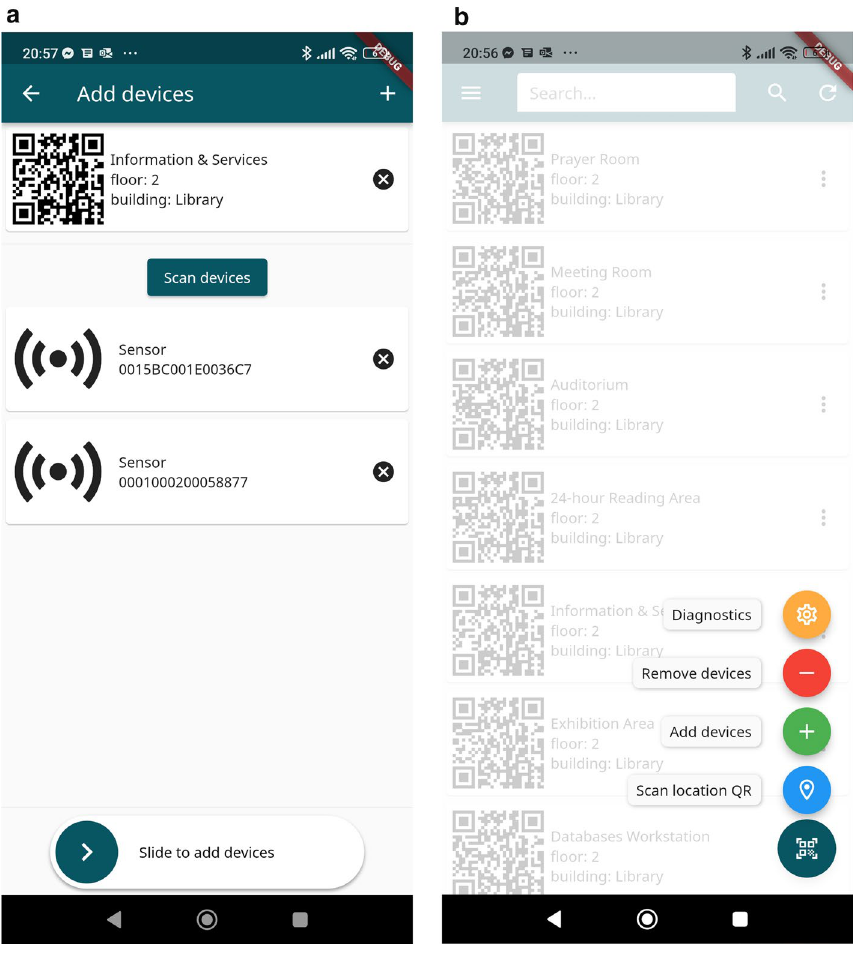
Fig. 3 Cross-platform registering